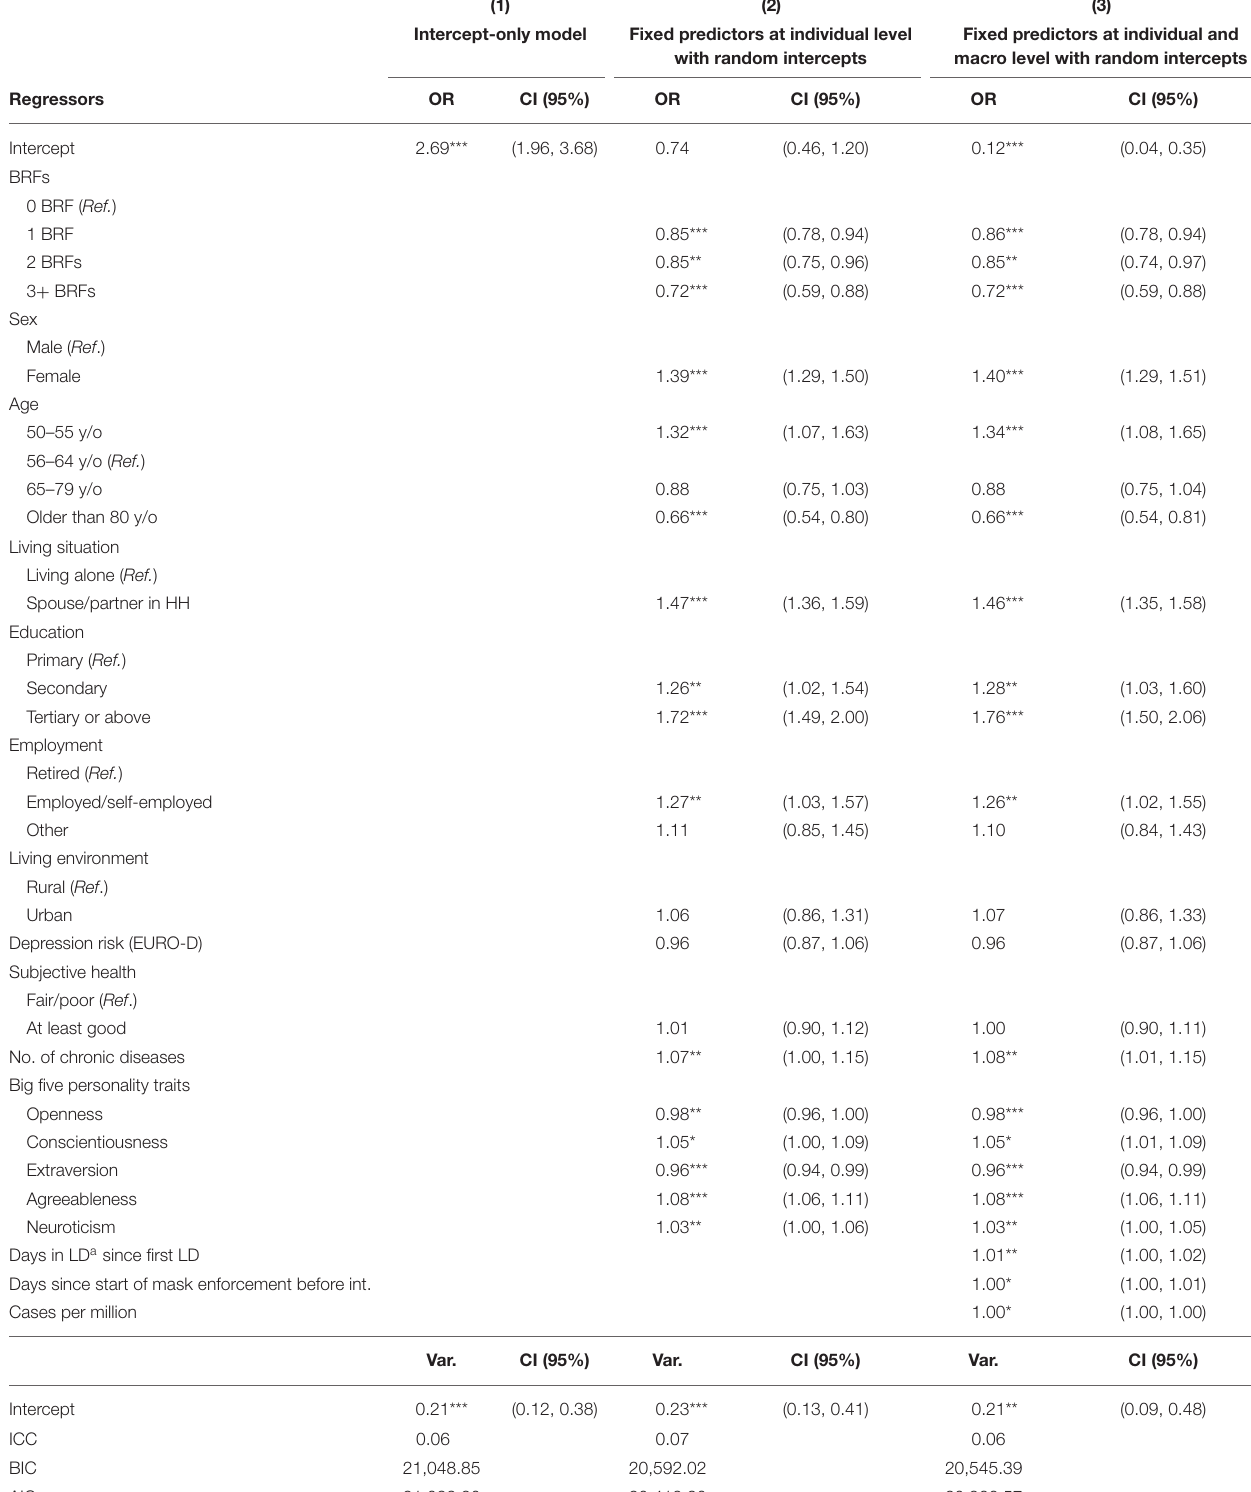
TABLE 4 | Multilevel analyses predicting adherence to hygiene measures ( n = 17.588), Data: Wave 8 Release 0.0.1 beta. (1) (2) (3) Intercept-only model Fixed predictors at individual level Fixed predictors at individual and with random intercepts macro level with random